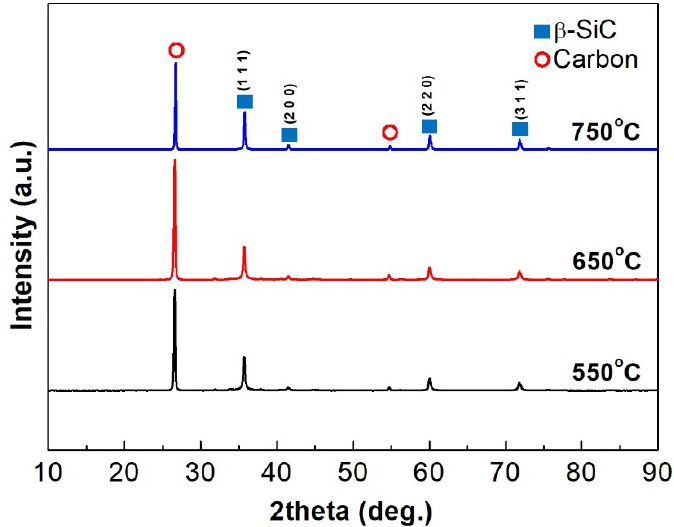
Figure 7. XRD patterns of the obtained SiC with different Si sludge-to-C molar ratio at 1550 °C.